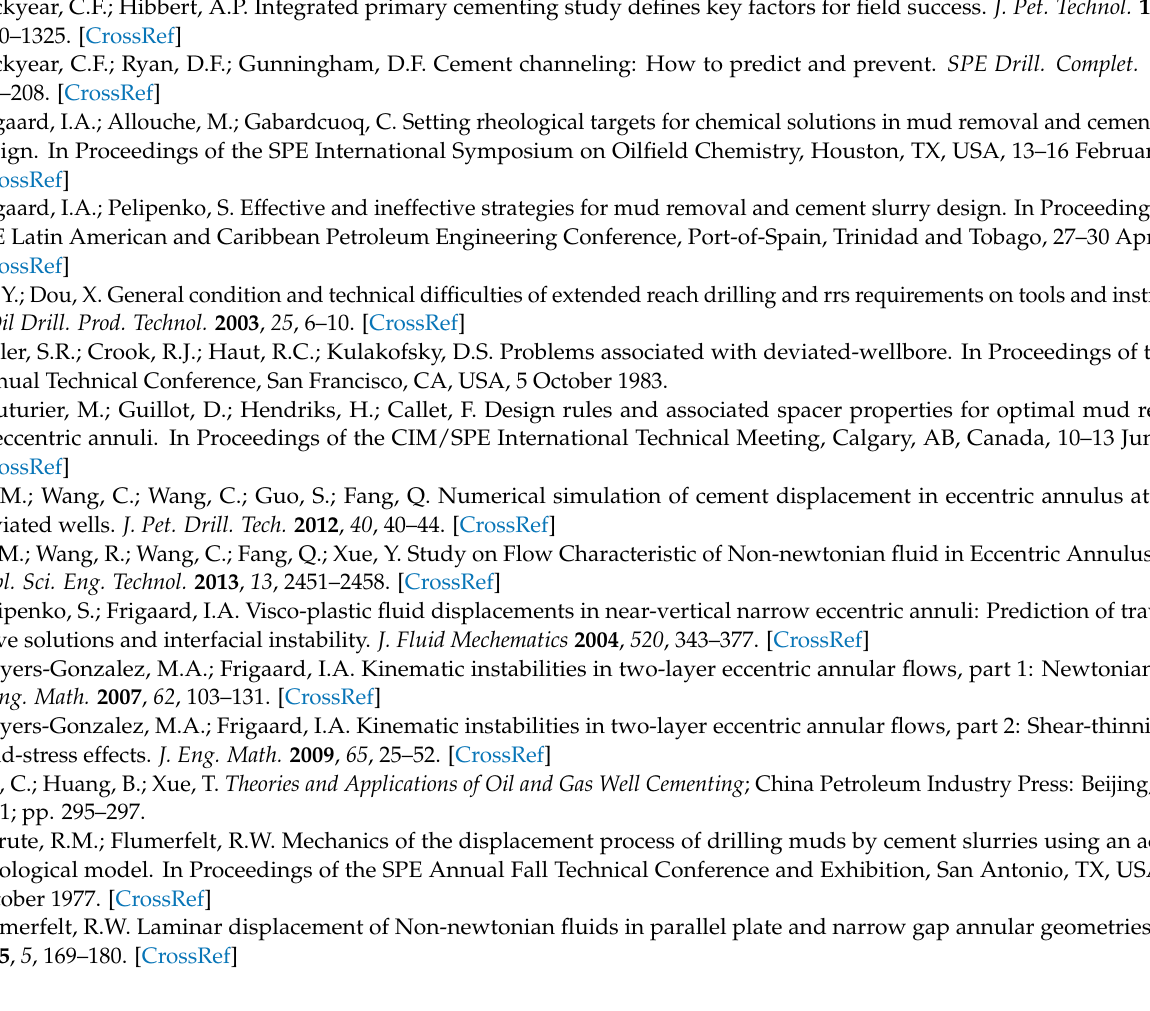
(2) The finite difference method can effectively solve the theoretical model. The analysis shows that: with the increase of well deviation angle, the cement displacement inter- face length gradually extends, and under the same injection conditions, the well with a larger well deviation angle has a poor cement displacement effect. Increasing the ap- parent viscosity of cement slurry is beneficial to improve the stability of displacement interface. In highly deviated wells, a certain casing eccentricity can inhibit the uneven penetration of cement slurry in the annulus, which is conducive to maintaining the stability of the displacement